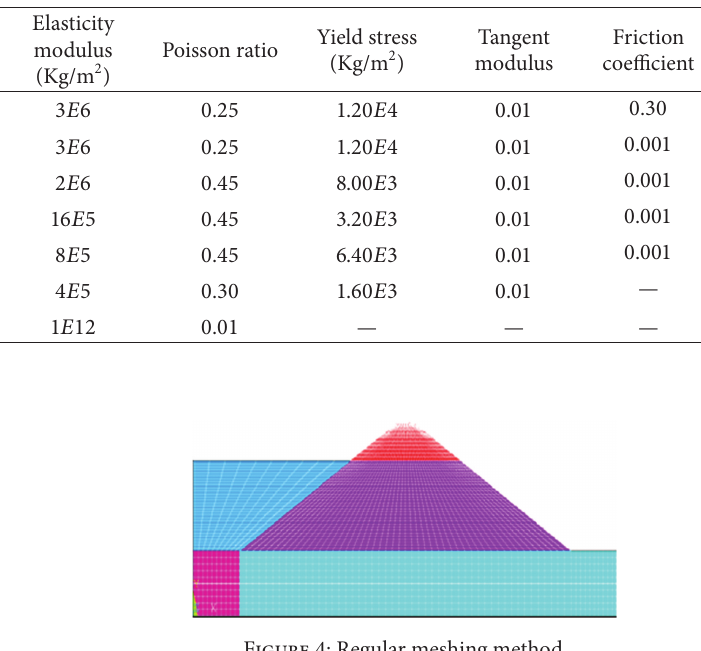
Figure 4: Regular meshing method.